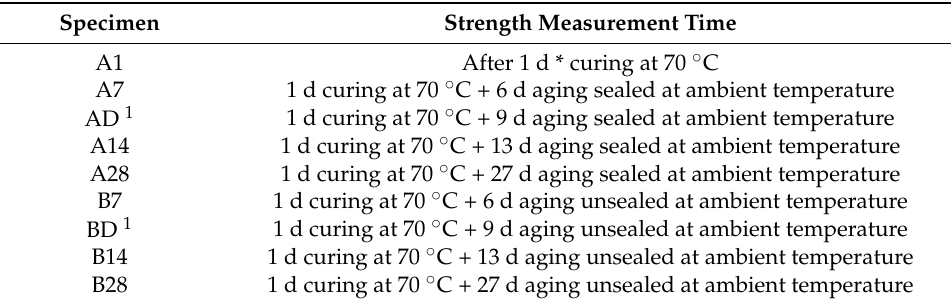
Table 1. Description of geopolymer specimens and their curing regime.